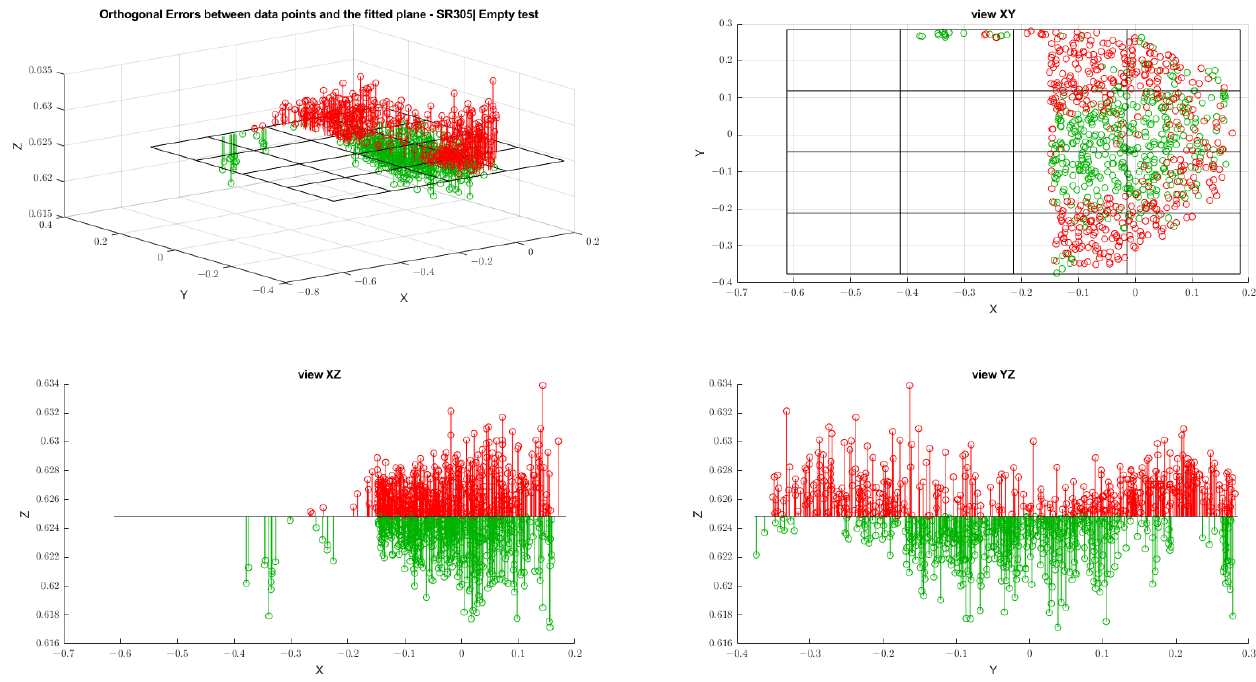
Figure A16. Results of orthogonal errors for the SR305 camera referring to the empty